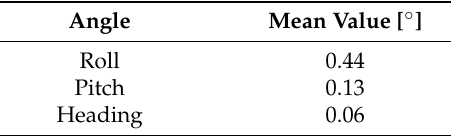
Figure 5. Attitude estimates under stationary conditions. Table 1. Attitude estimates results.